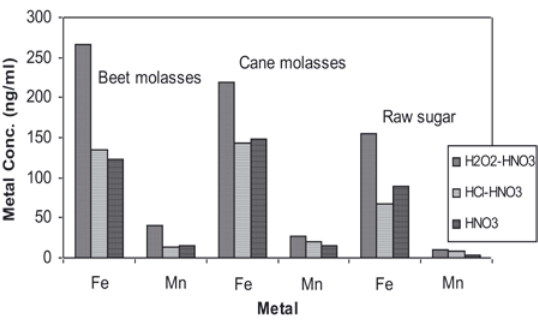
Figure. 5. The effect of solvent system on the ultrasonic assisted acid digestion of iron and manganese from CAFM samples.